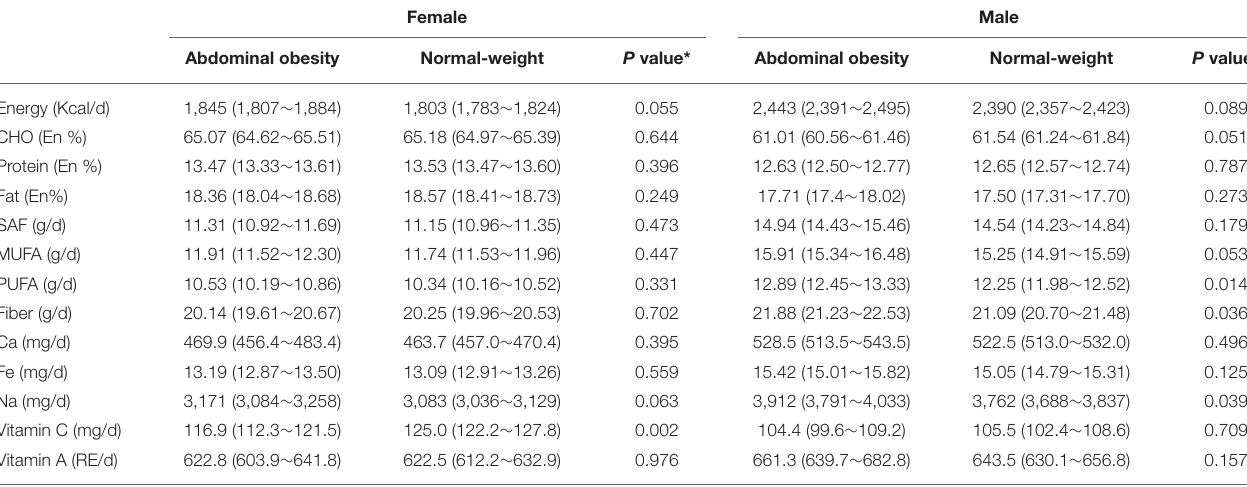
TABLE 3 | Adjusted mean ¶ and 95% CI of major nutrient intake according to genders and abdominal obesity calculated by waist circumference.